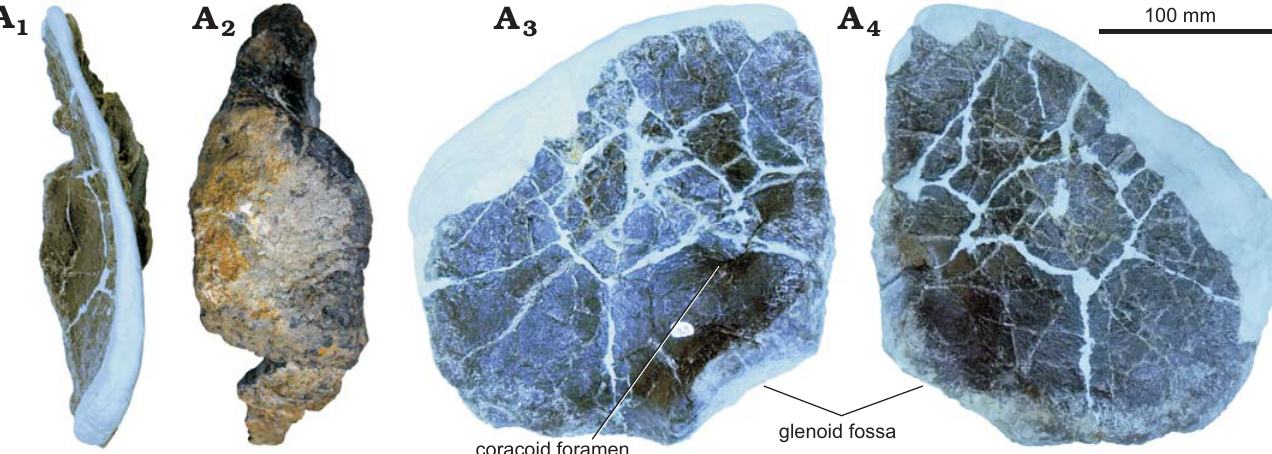
Fig. 14. Left coracoid of stegosaur GPDM 178, near Giffen, Cascade County, Montana; in anterior (A 1 ), lateral (A 2 ), posterior (A 3 ), and anterior (A 4 ) views.